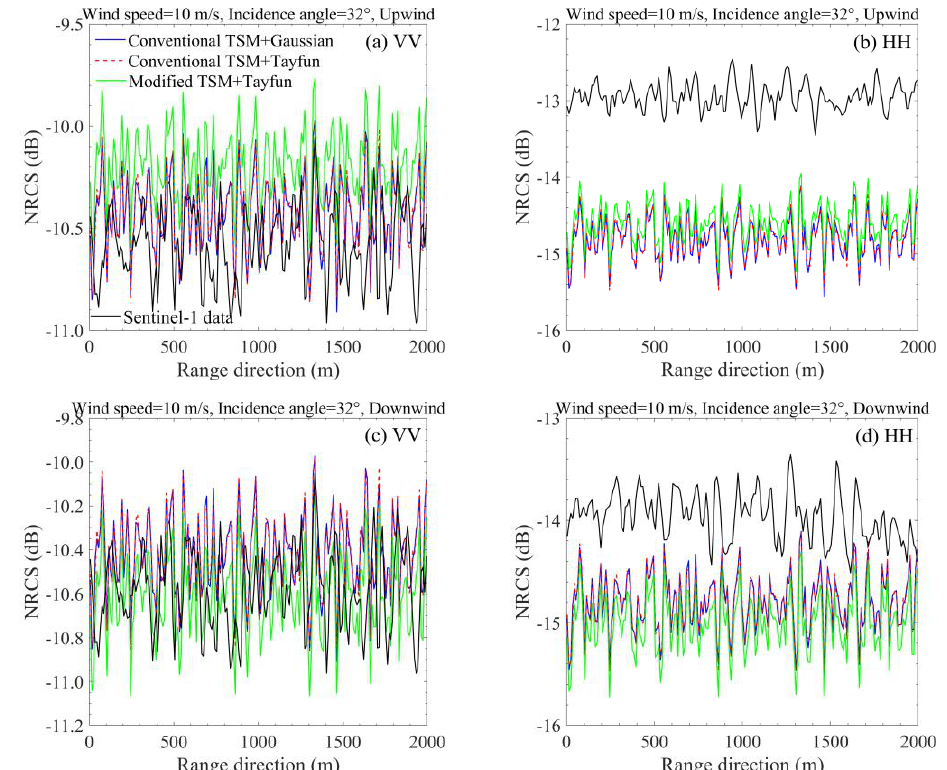
Figure 13. Examples of the scattering profiles predicted based on the conventional TSM + Gaussian sea surface, the conventional TSM + Tayfun sea surface, and the modified TSM + Tayfun sea surface and their comparison with Sentinel-1 data at 32° incidence angle and 10 m/s wind speed ( a , b ) in the upwind direction under VV and HH polarizations and ( c , d ) in the downwind direction under VV and HH polarizations. Blue solid curve, conventional TSM + Gaussian sea surface; red dashed curve, conventional TSM + Tayfun sea surface; green solid curve, modified TSM + Tayfun sea surface; black solid curve, Sentinel-1 data.